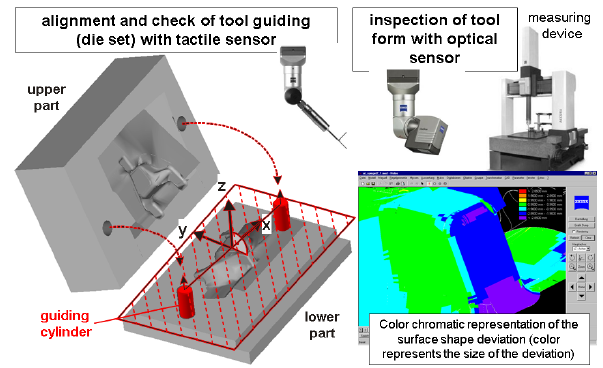
Figure 9. Procedure for characteristic (top) and part-oriented (be- low) acquisition of product